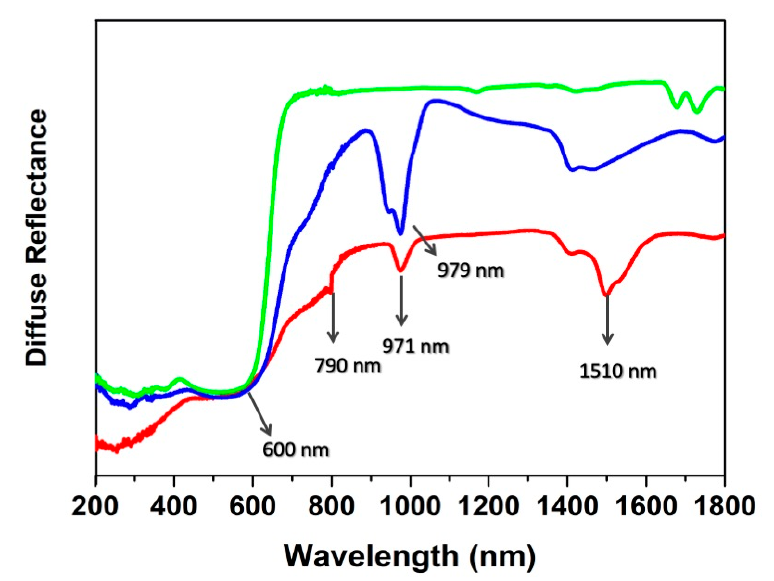
Figure 8. Diffuse reflectance spectra of 1 (blue line), 2 (red line) and 3 (green line).